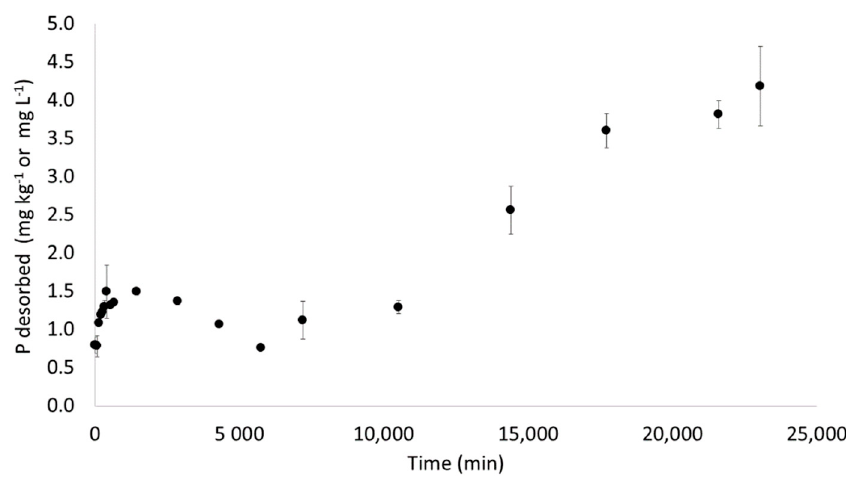
Figure 2. Phosphorus (P) desorbed with time as cumulative mg kg − 1 soil and solution concentration using a standard batch test method with constant solution:soil ratio (1:1). Error bars = standard deviation. Since extraction ratio = 1:1 solution:soil, mg kg − 1 = mg L − 1 .